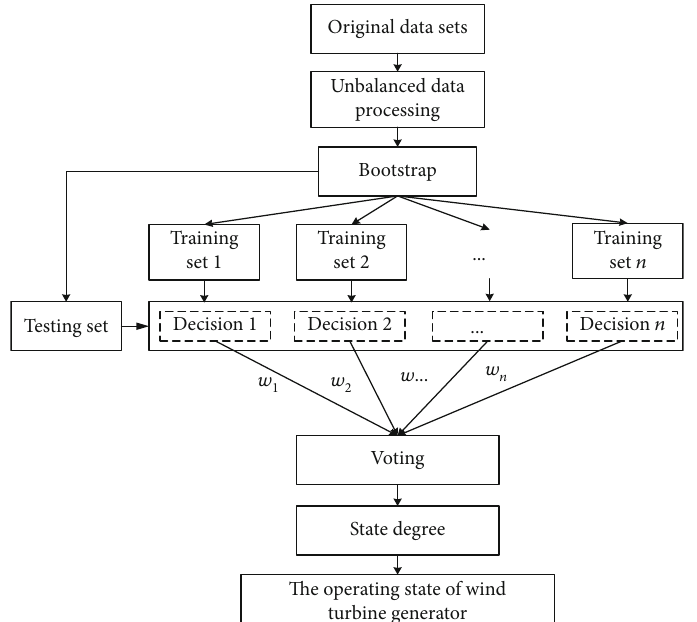
Figure 1: The assessment fl owchart of